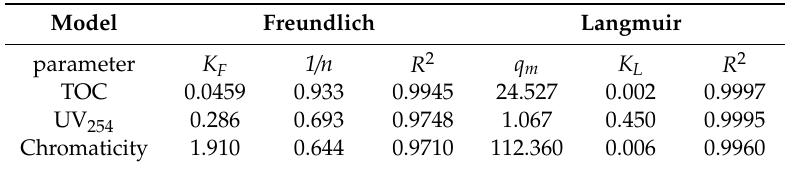
Table 3. Isotherm constant fittings for TOC, UV 254 and Chromaticity adsorption with Langmuir and Freundlich models.